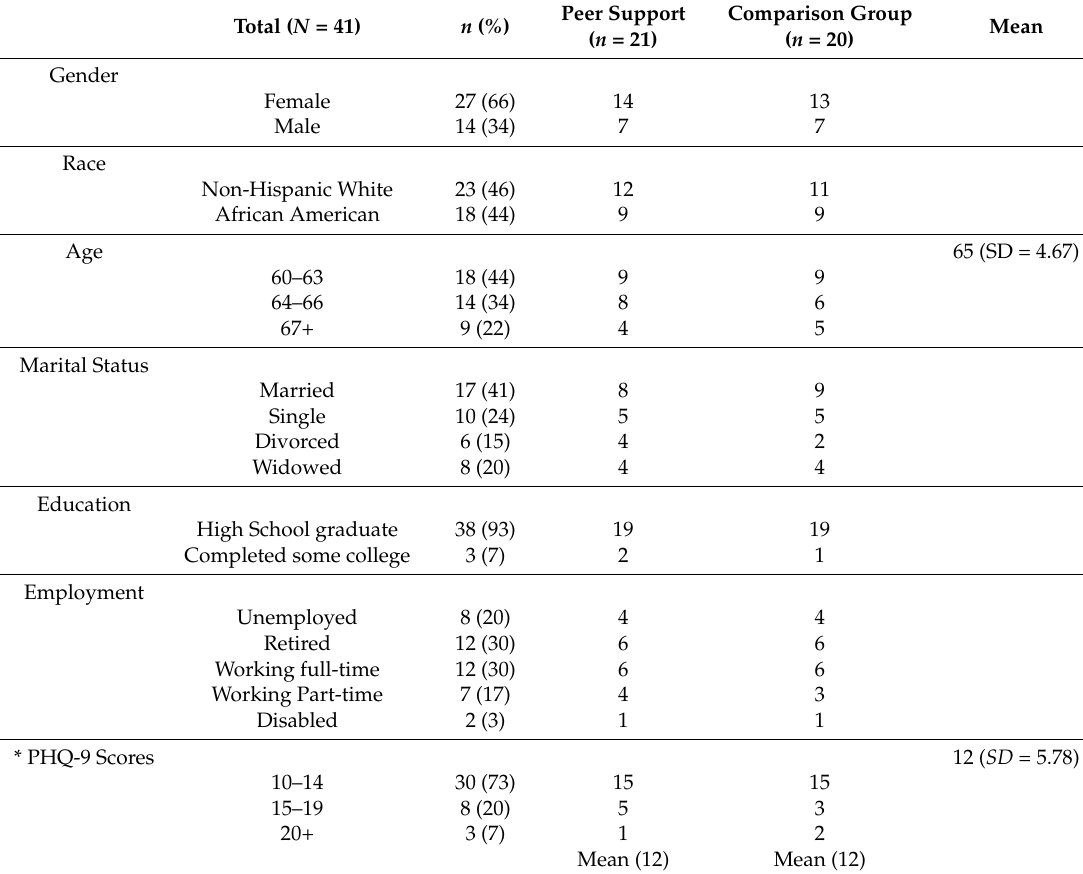
Table 3. Sample Characteristics by